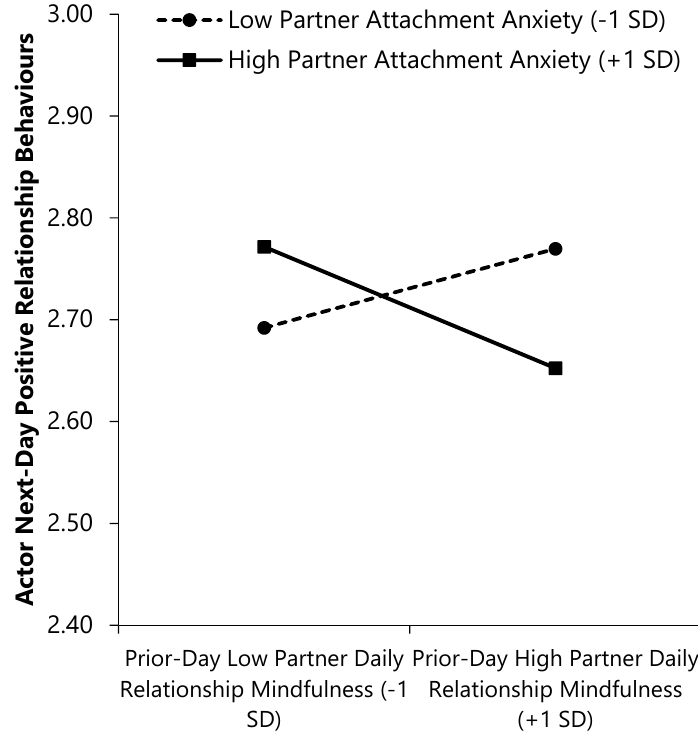
Figure 2. Interactions of attachment anxiety and prior-day relationship mindfulness with next-day positive relationship behaviours. Higher scores on continuous variables represent greater standing on the variable (e.g., higher daily RM).